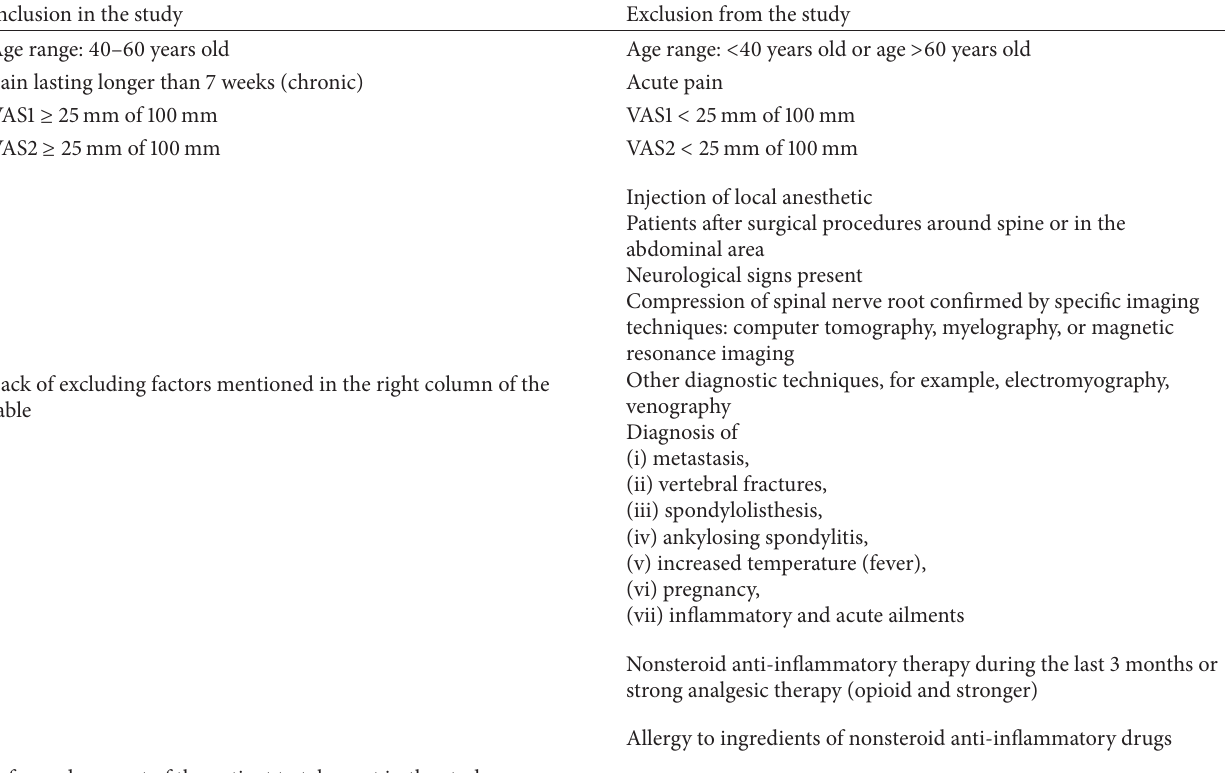
Table 1: Criteria for inclusion or exclusion.